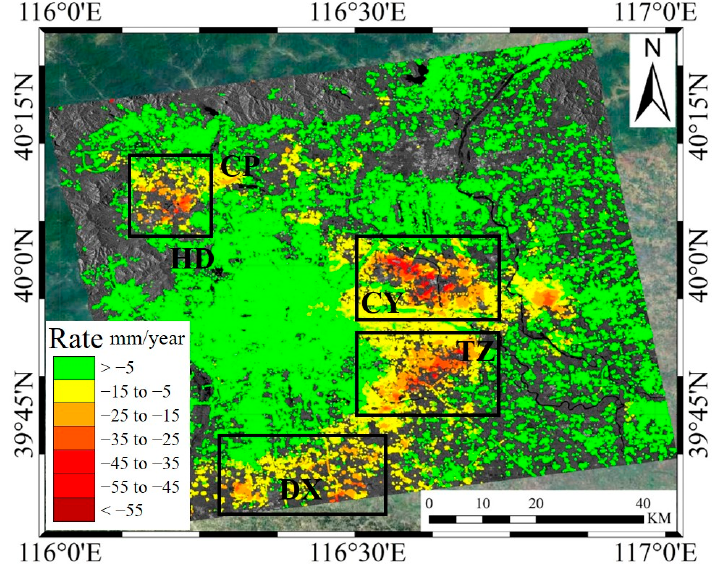
Figure 5. Surface subsidence rate in Beijing from February 2020 to April 2022 (after the COVID-19 outbreak). ‘CP’ is Changping District, ‘HD’ stands for Haidian District, ‘CY’ is located in Chaoyang District, ‘TZ’ means Tongzhou District and ‘DX’ is Daxing District.